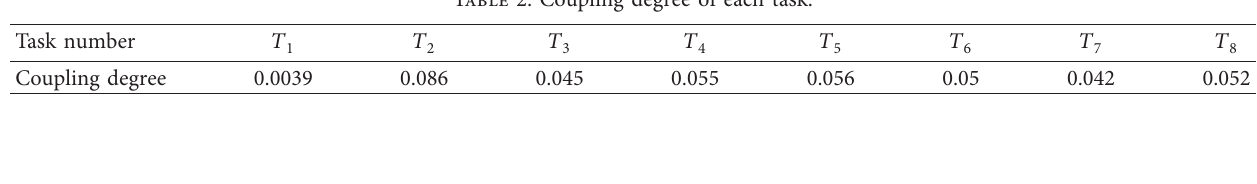
Table 3: Importance of each task.